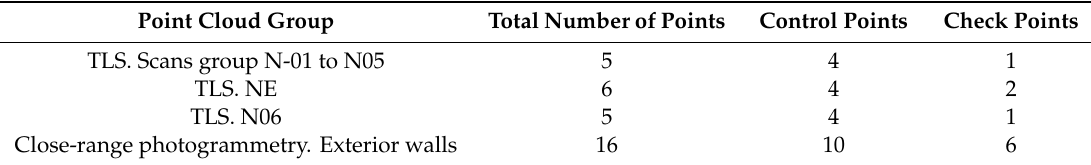
Table 2. Number of check and control points for scaling and georeferencing the point clouds. Point Cloud Group Total Number of Points Control Points Check Points TLS. Scans group N-01 to N05 5 4 1 TLS. NE 6 4 2 TLS. N06 5 4 1 Close-range photogrammetry. Exterior walls 16 10